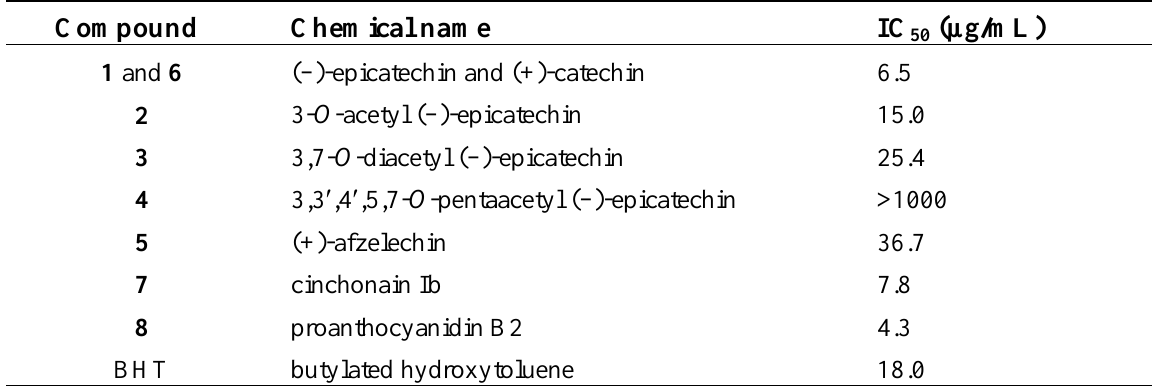
Table 1. The IC (µg/mL) of compounds 1 – 8 in DPPH radical scavenging 50